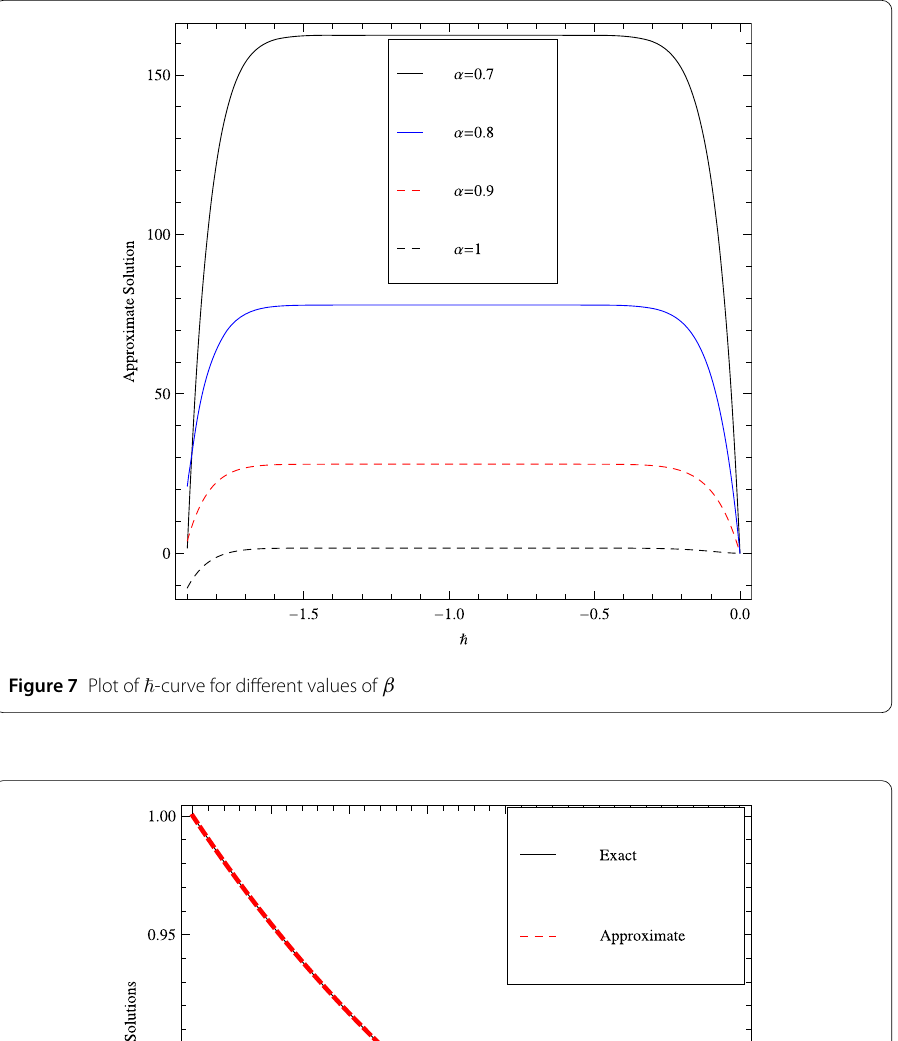
Figure 7 Plot of (cid:2) -curve for different values of β